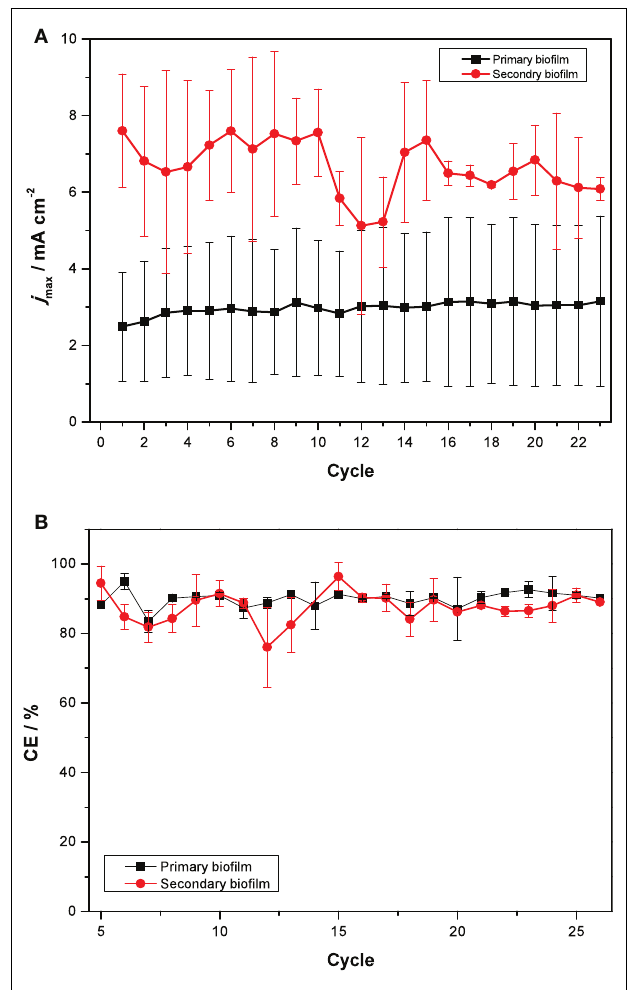
FIGURE 5 | Maximum peak current density (A) and Coulombic efficiency (B) data from long-term experiments generated by primary (black) and secondary biofilms (red) .The data shown represents the arithmetic mean of two duplicates.The error bars indicate the standard deviation.